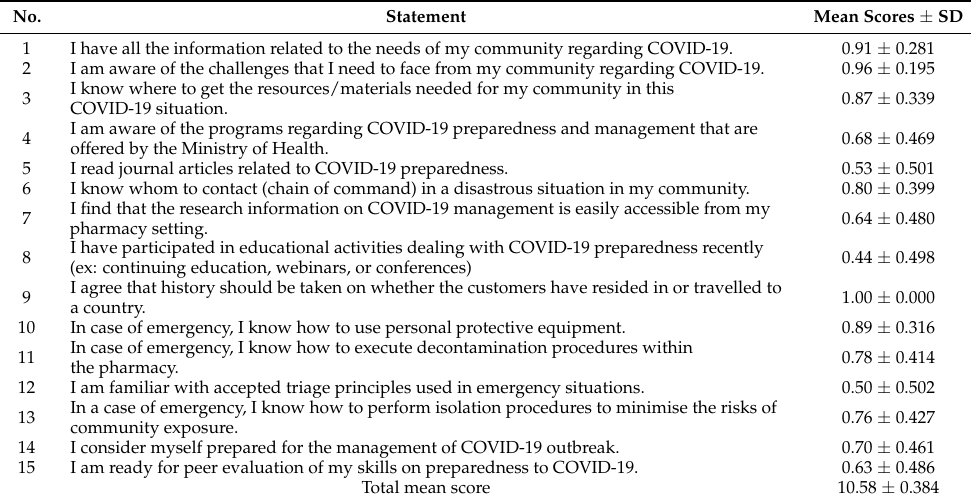
Table 2. Participants’ preparedness scores towards COVID-19.